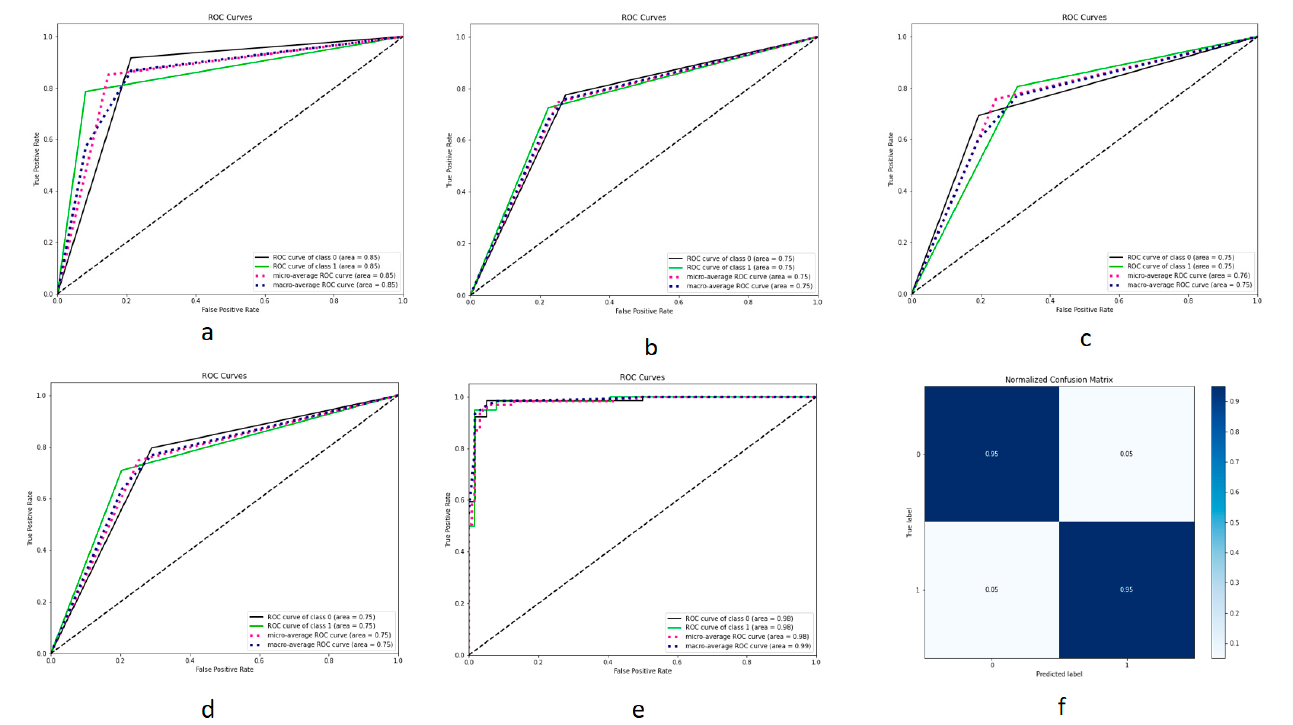
Figure 4. Receiver operator characteristic curves for ( a ) Least Absolute Shrinkage and Selection Operator (LASSO), ( b ) Random Forest (RF), ( c ) Support Vector Machine (SVM), ( d ) eXtream Gradient Boosting (XGBoost), and ( e ) Artificial Neural Network (ANN), and ( f ) confusion matrix for best- performing ANN model.